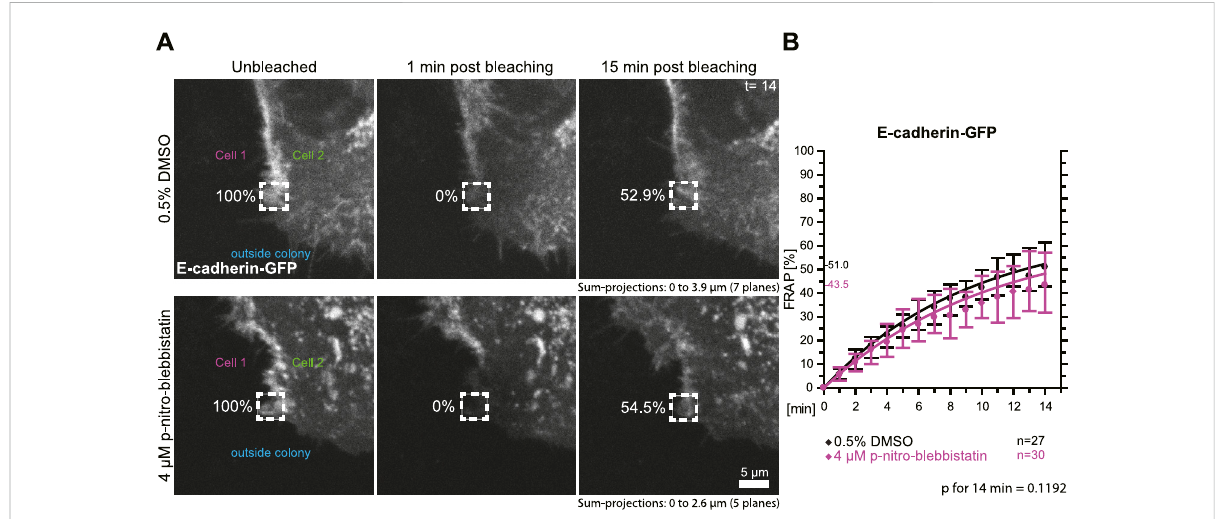
FIGURE 6 MyosinIIinhibitiondoesnotsigni fi cantlyaffecttheturnoverofE-cadherinatcellborders.HaCaTkeratinocytesweretransfectedwithaplasmid encoding human E-cadherin-GFP. (A) Regions at cell colony borders were selected for FRAP. Sum-projections of fl uorescence were generated and are shown from left to right prior to, 1 and 15 min after photobleaching. The relative fl uorescence measured in the regions of interest are given in %. Cellswereeitherincubatedwithcontrolmedium(top)orwith4 µMpara-nitro-blebbistatin(bottom).The fi rstsum-projectionshowscomplete E-cadherin-GFP signal in a peripheral cell that is next to a non-transfected cell directly before bleaching. (B) The diagram depicts the fl uorescence recoverycurvesofE-cadherin-GFPfrom1to15 minafterphotobleaching.Dotsrepresentmedians,whiskerscorrespondtothe25 – 75thpercentiles, and statistical analysis was performed with a Mann-Whitney test for the last